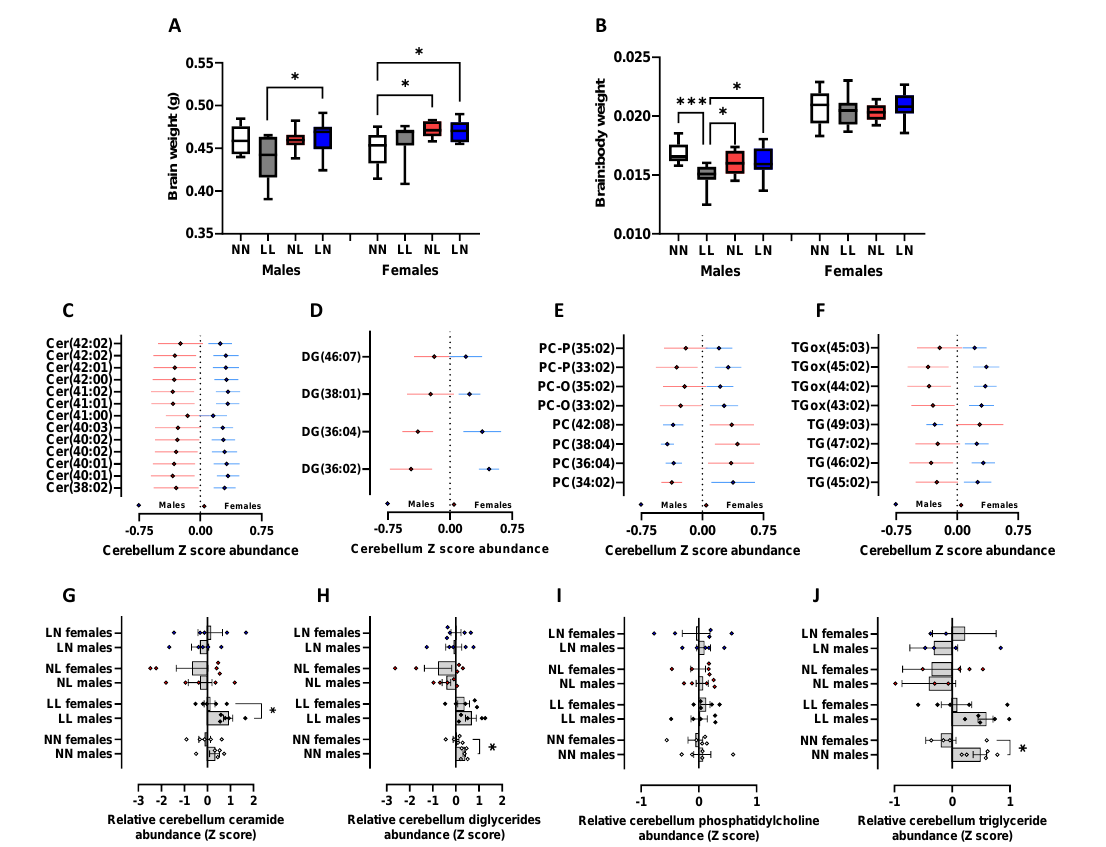
Figure 5. Impact of paternal diet on F1 adult offspring brain tissue lipid profiles: ( A ) the brain weight and ( B ) brain:body weight ratio of NN (NPD sperm and LPD seminal plasma), LL (LPD sperm and LPD seminal plasma), NL (NPD sperm and LPD seminal plasma) and LN (LPD sperm and NPD seminal plasma) offspring at 16 weeks of age. Sex-specific differences in cerebellum ( C ) ceramides, ( D ) diglycerides (DG; water-loss product from fragmentation in source), ( E ) phosphatidylcholine (PC) and ( F ) triglycerides (TG) between male and female offspring. Sex-specific differences separated by dietary treatment group for ( G ) ceramides, ( H ) diglycerides (DG), ( I ) phosphatidylcholine (PC) and ( J ) triglycerides (TG). N = 10 offspring (five males and females) per treatment group, sampled from all litters generated. Data are expressed as mean ± SEM. * p < 0.05, *** p < 0.001. Statistical differences were determined using a random effects regression analysis ( A , B ) or Student’s t -test ( C – J ).